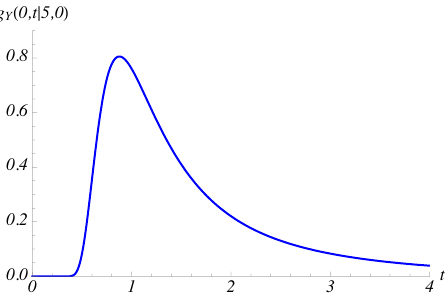
Figure 12. The FPT density (51) through the zero state is plotted for the same choices as Figure 6 with (cid:0) (cid:1) 2 x 0 = 5 and σ 2 ( t ) = 2 1 − e − 1.2 t